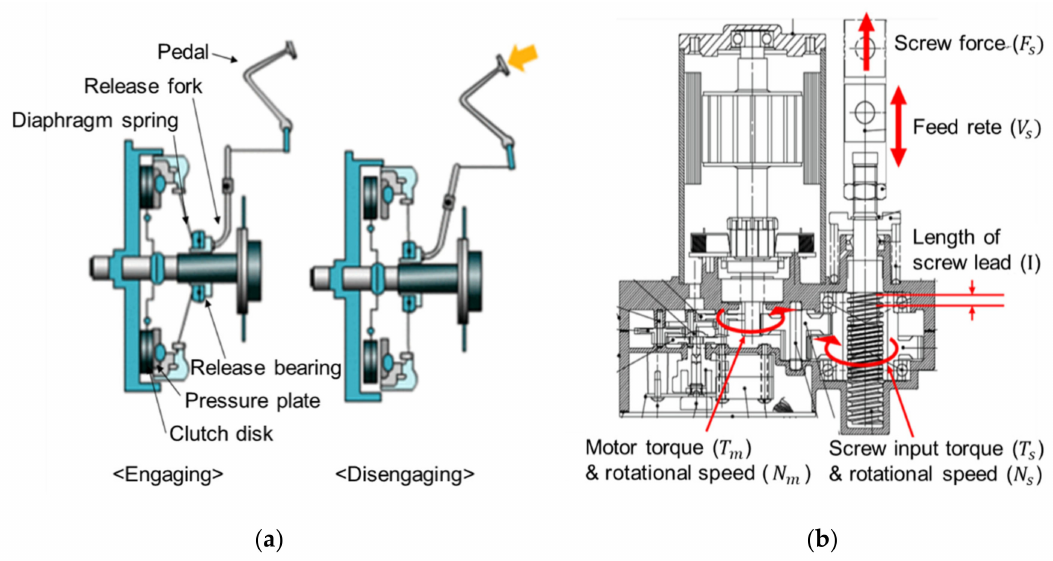
Figure 3. ( a ) Operating principle of a friction clutch; and ( b ) clutch actuator for automated clutch